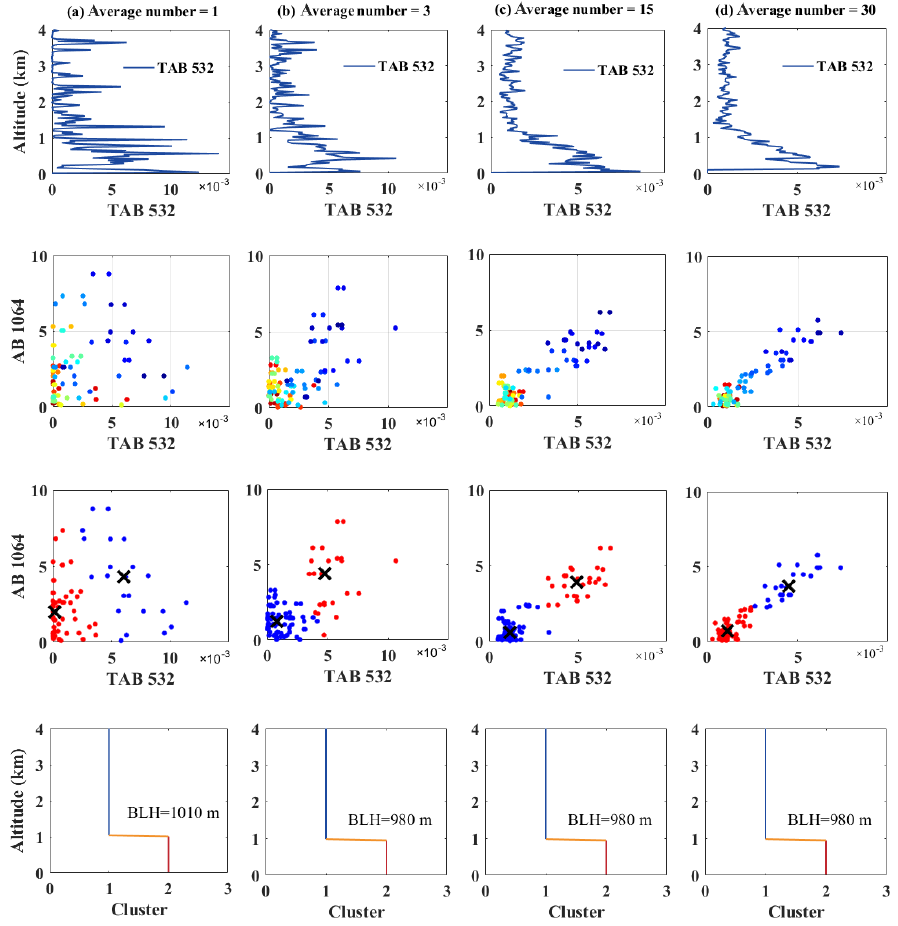
Figure 5. Case study of CALIPSO data with different horizontal smoothing numbers on 4 October 2013 over Wuhan area. (a) Average number = 1, (b) average number = 3, (c) average number = 15 and (d) average number = 30. The blue line represents the vertical profile of TAB 532 derived from CALIPSO data, the black cross represents the centroid of the cluster and the orange horizontal line represents the BLH